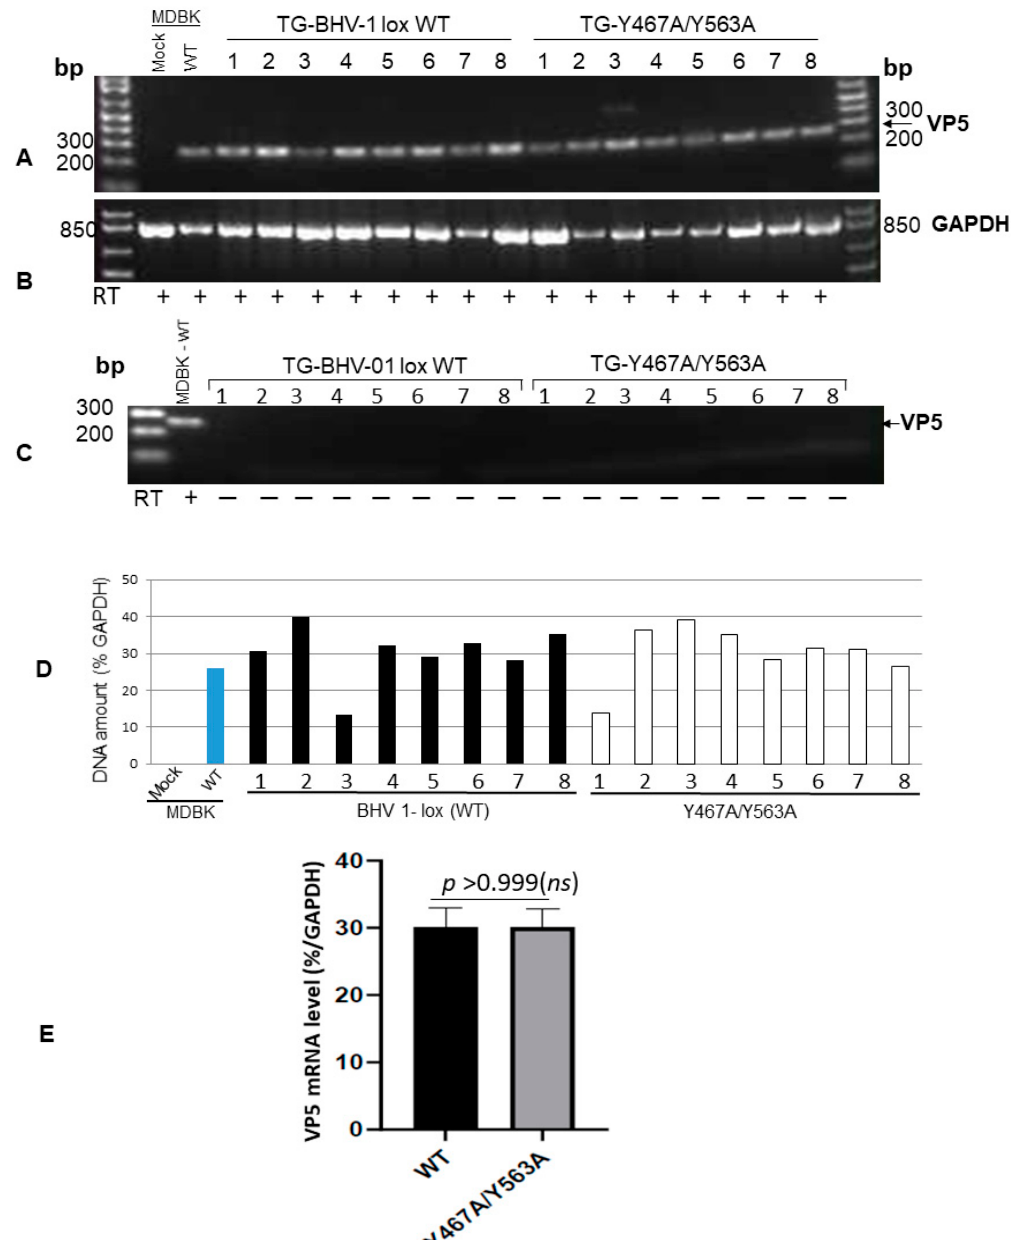
Figure 4. RT-PCR amplification of BHV-1 VP5 (251-bp)-specific mRNA sequence from TGs of rabbits